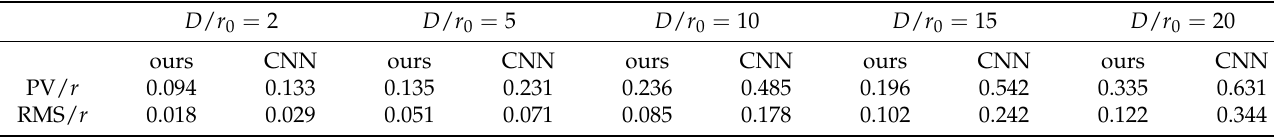
Figure 6. Comparison of the predicted turbulence phase with the actual phase: ( a ) actual phase; ( b ) predicted phase; ( c ) residual phase; ( d ) prediction results of the literature [12].